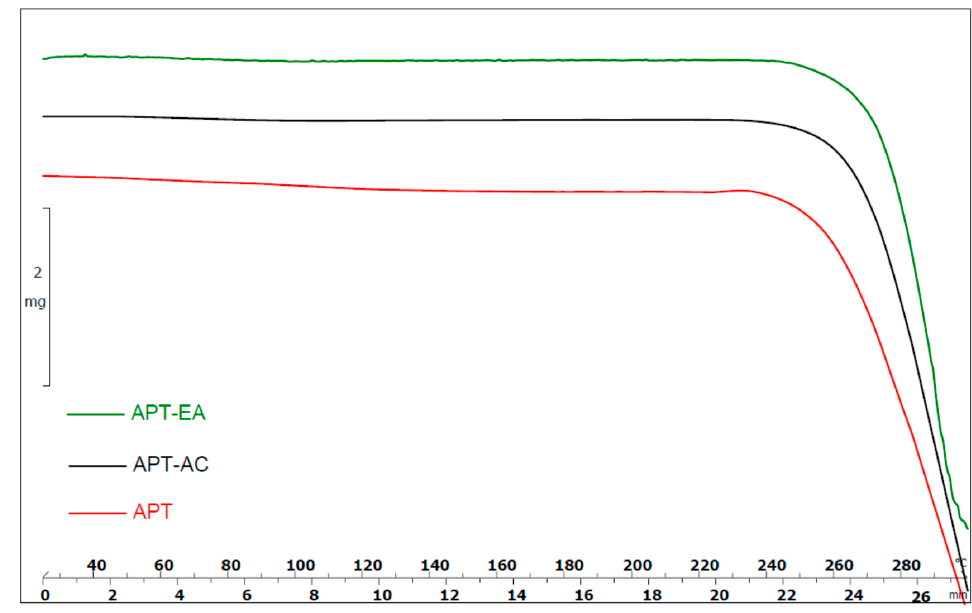
Figure 3. Thermogravimetric